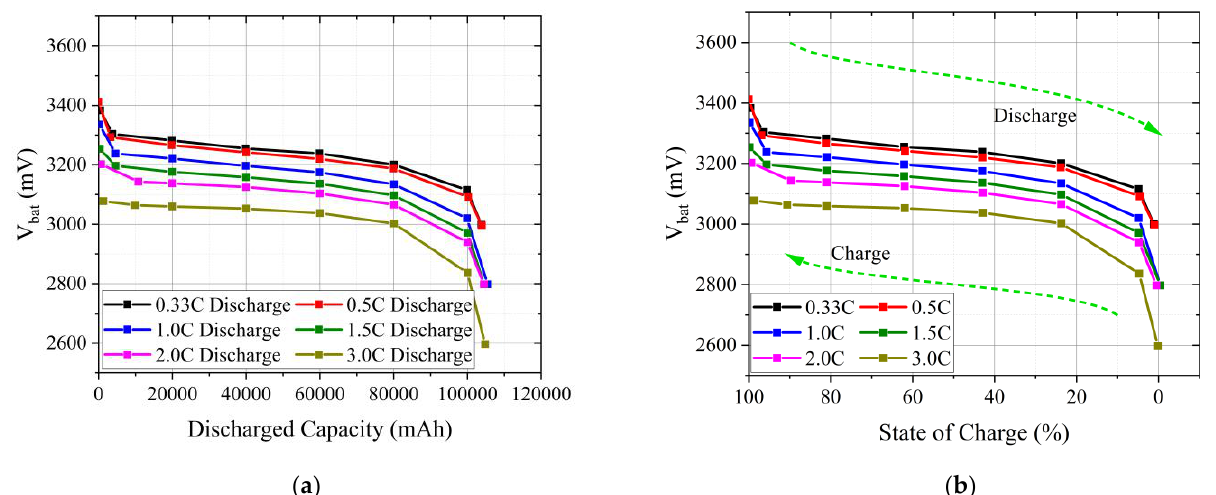
Figure 4. Variations in battery terminal voltage for different charge – discharge currents: ( a ) manufacturer data [12]; ( b ) simulation results.